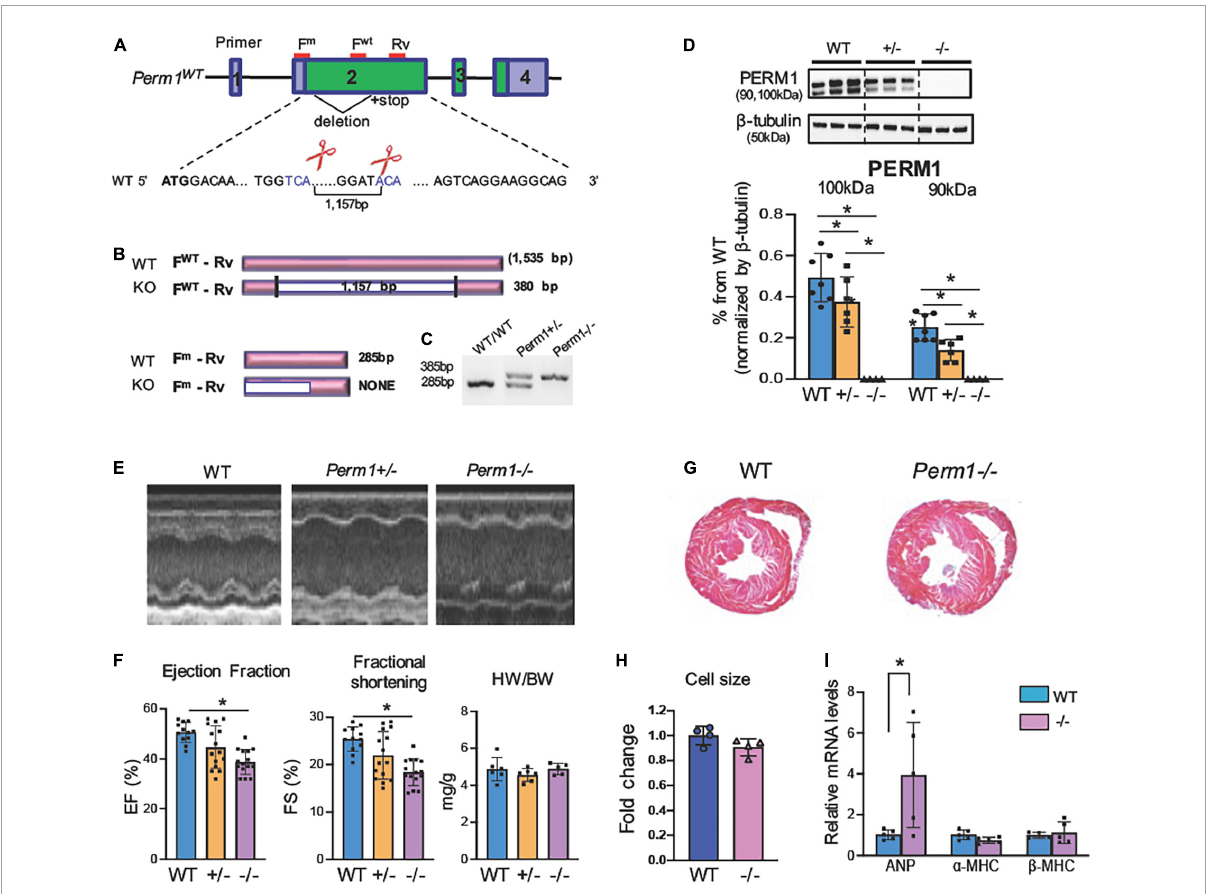
FIGURE1 (A) Perm1 − / − (KO) mice exhibit reduced cardiac function (age, 3 months). (Schematic of Perm1 gene and the CRISPR/Cas9-mediated gene editing in Perm1 loci in C57BL/6 mice. Exon 2 was targeted, where the primers for genotyping are indicated in red lines (F WT + Rv for WT; F m + Rv for mutant). (B) Schematic of PCR products from WT and CRISPR/Cas9 mice (KO). PCR with the primer set, F WT + Rv, distinguishes WT (not detected) from either Perm1 ± or Perm1 − / − (360-bp band), while PCR with the primer set, F m + Rv, distinguishes WT (285 bp) from Perm1 ± or Perm1 − / − mice (not detected). (C) Genotyping of WT, Perm1 ± and Perm1 − / − mice using those primers. (D) Western blotting analysis showing the reduced endogenous levels of PERM1 in Perm1 ± and Perm1 − / − hearts ( n = 6/group). (E) Sample 2D echocardiographs from WT, Perm1 ± and Perm1 − / − mice. (F) Ejection fraction (EF), fraction shortening (FS), and the heart weight (mg)–body weight (g) ratios (HW/BW) of WT, Perm1 ± and Perm1 − / − mice ( n = 15/group). (G) Low-magnification views of hematoxylin/eosin stains of transverse sections of WT and Perm1 − / − hearts. (H) Quantification of cell size in WT and Perm1 − / − hearts ( n = 5/group). (I) qPCR of ANF, α -MHC, and β -MH in WT and Perm1 − / − hearts ( n = 5/group). * p < 0.05.